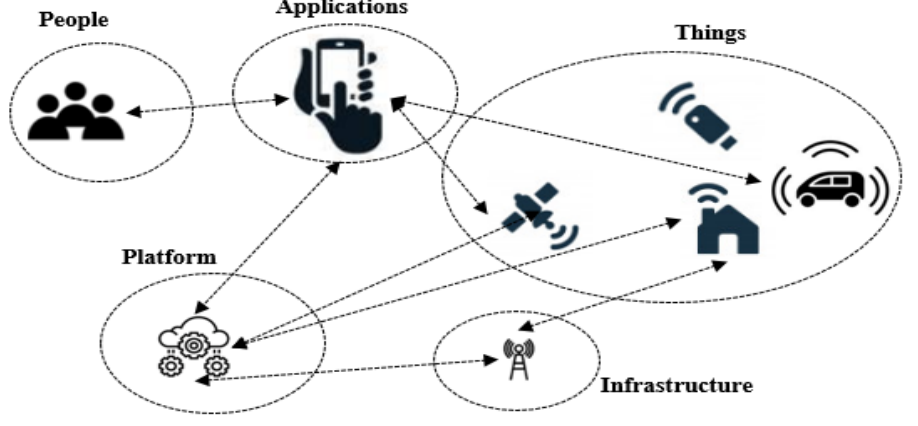
Figure 1. Key elements of an IoT-based system.